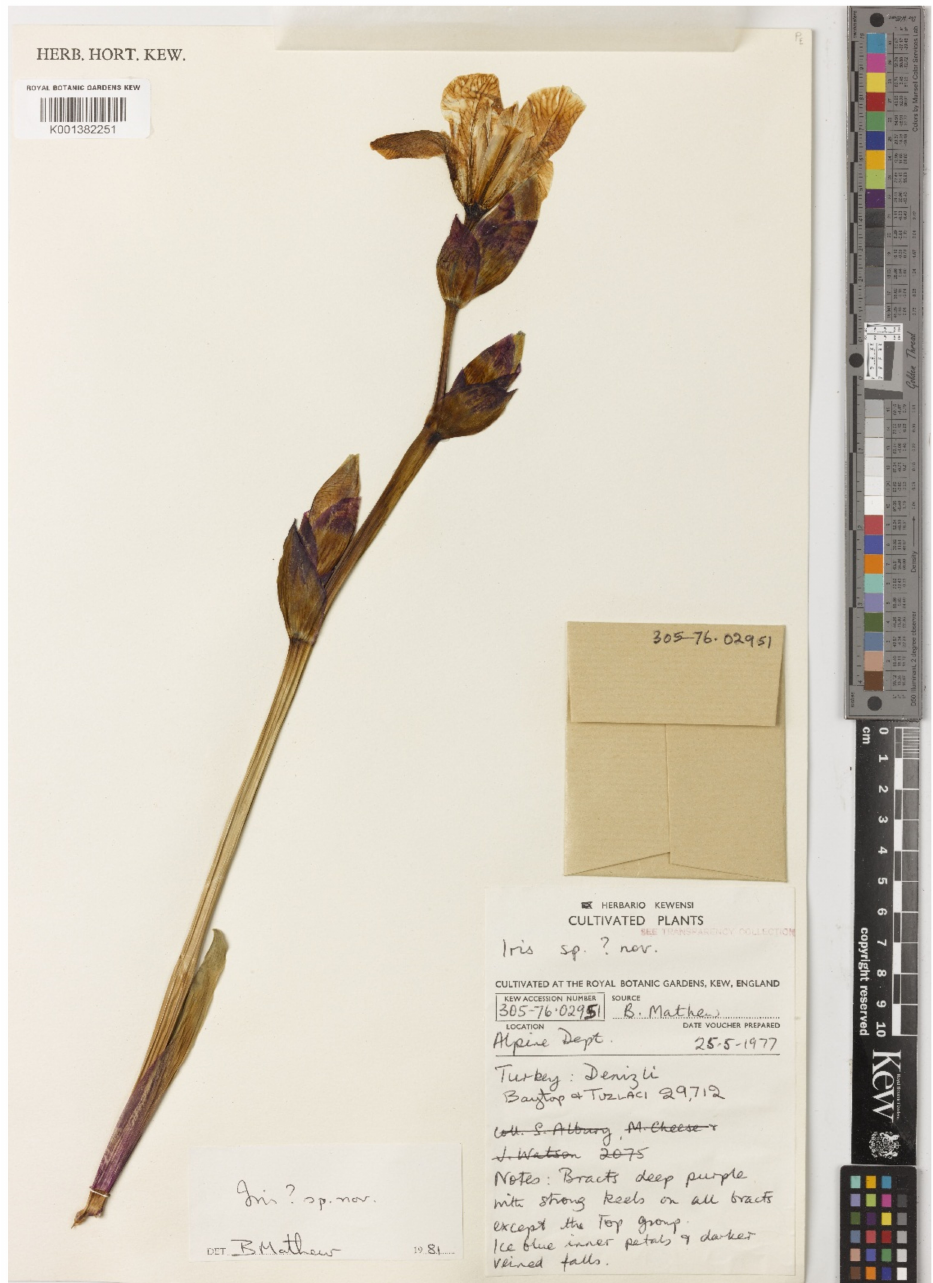
Figure 4. Lectotype of Iris purpureobractea (K001382251). Reproduced with the consent of the Royal Botanic Gardens,